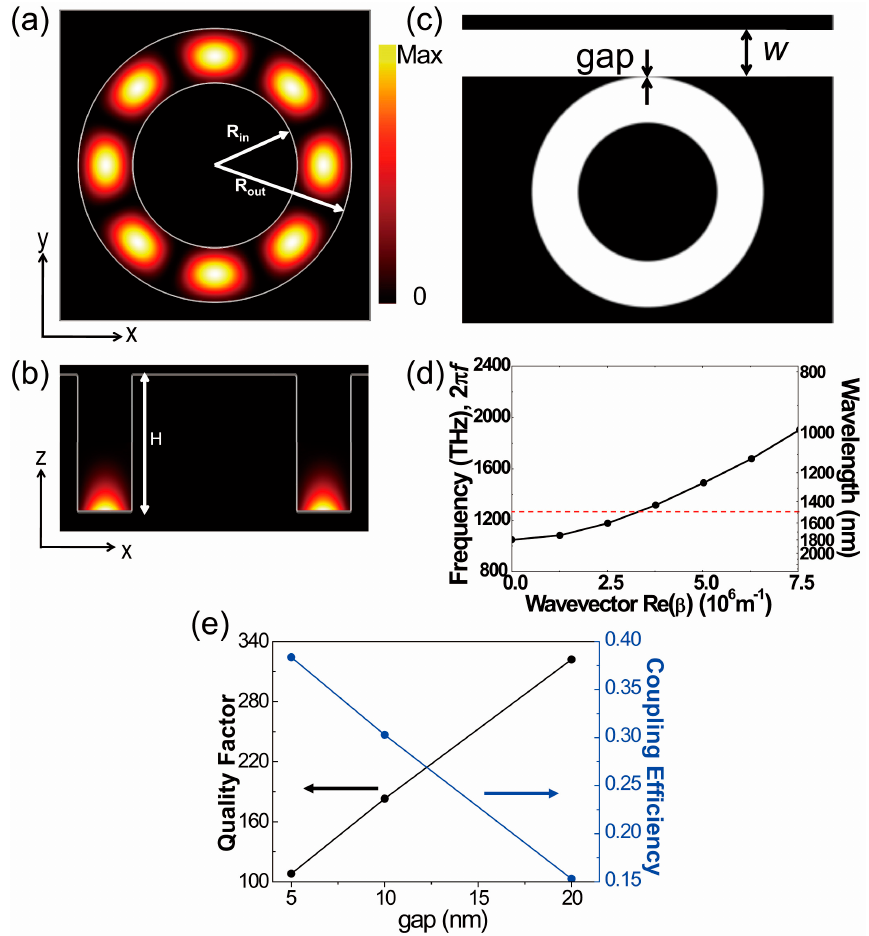
Figure 2. Electric field intensity profiles of the plasmonic whispering gallery mode in ( a ) top view and ( b ) cross-sectional view. The top view is achieved at the plane 20 nm above the bottom of the ring cavity. The outer and inner radii ( R out and R in ) of the ring cavity are 1500 nm and 900 nm, respectively. The depth ( H ) of the ring cavity is 1500 nm. ( c ) The waveguide with a width w of 600 nm is coupled with the ring cavity of Figure 2a. A silver wall with a gap thickness of 10 nm separates the waveguide and the cavity. ( d ) The dispersion curve of the rectangular groove waveguide with a width of 600 nm and a depth of 1500 nm. The red dotted line indicates 1518 nm, the resonant wavelength of the ring cavity. ( e ) The quality factor (black) and coupling efficiency (blue) as a function of gap thickness.